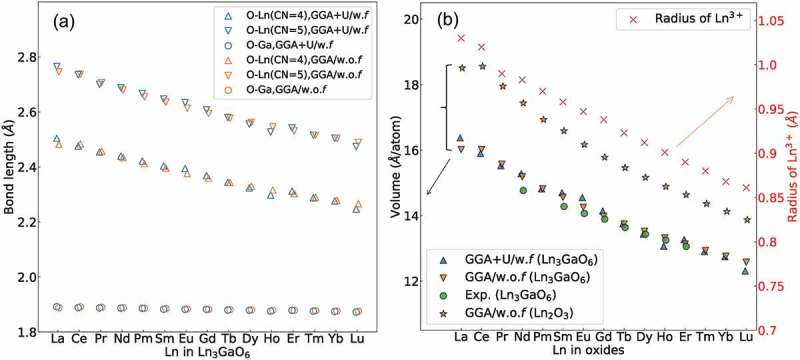
(a) Mean bond lengths of 15 Ln3GaO6 and (b) volume (eV/atom, left vertical axis) of 15 Ln3GaO6 and Ln2O3, and Ln3+ radius (right vertical axis). The experimental values of volume and the radius of Ln3+ are from Refs. [15] and [45], respectively.